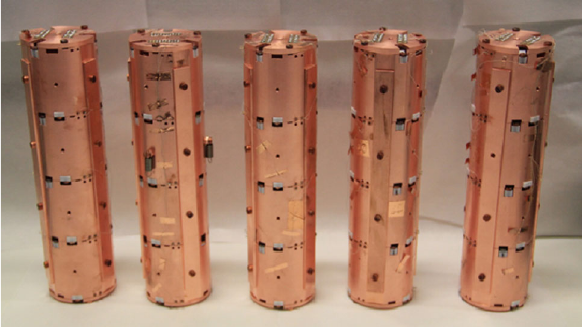
Fig. 6 The five assembled towers before installation in the cryogenic